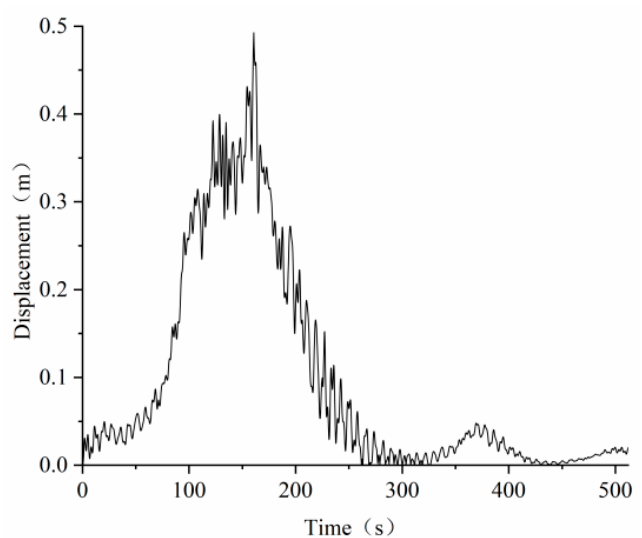
Figure 18. Displacement time history of transmission tower under 60 m/s downburst.